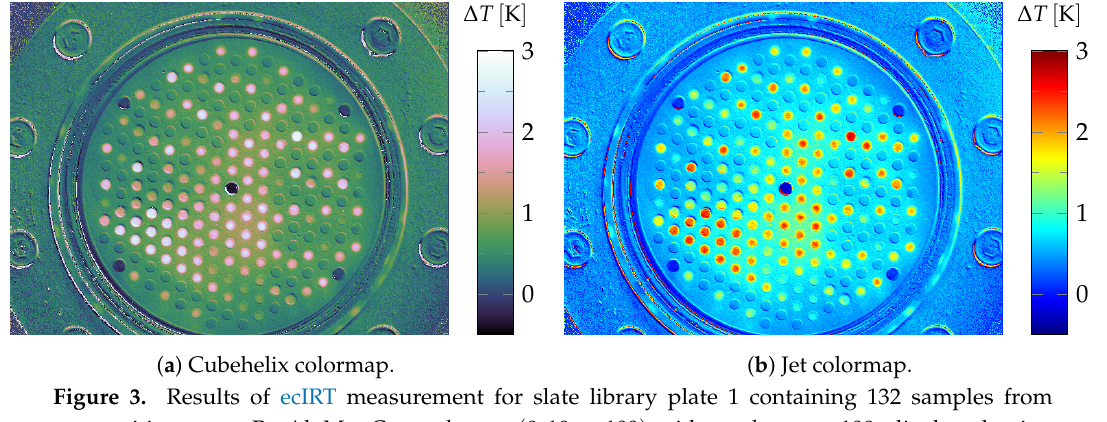
Figure 3. Results of ecIRT measurement for slate library plate 1 containing 132 samples from ( 0,10,...,100 ) with a + b + c = 100, displayed using composition range Pt 3 Al a Mn b Ce c , a , b , c ∈ different colormaps. 2vol.% CH 4 , 8vol.% O 2 , 12vol.% H 2 O, balance N 2 , 400 ◦ C.